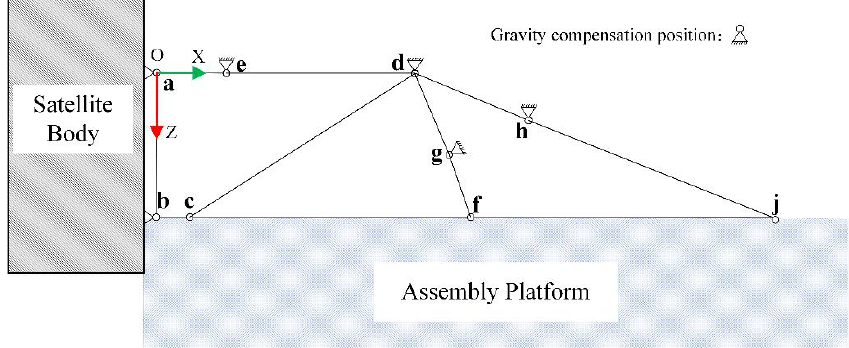
Figure 4. Assembly site schematic projection onto the X-O-Z plane.